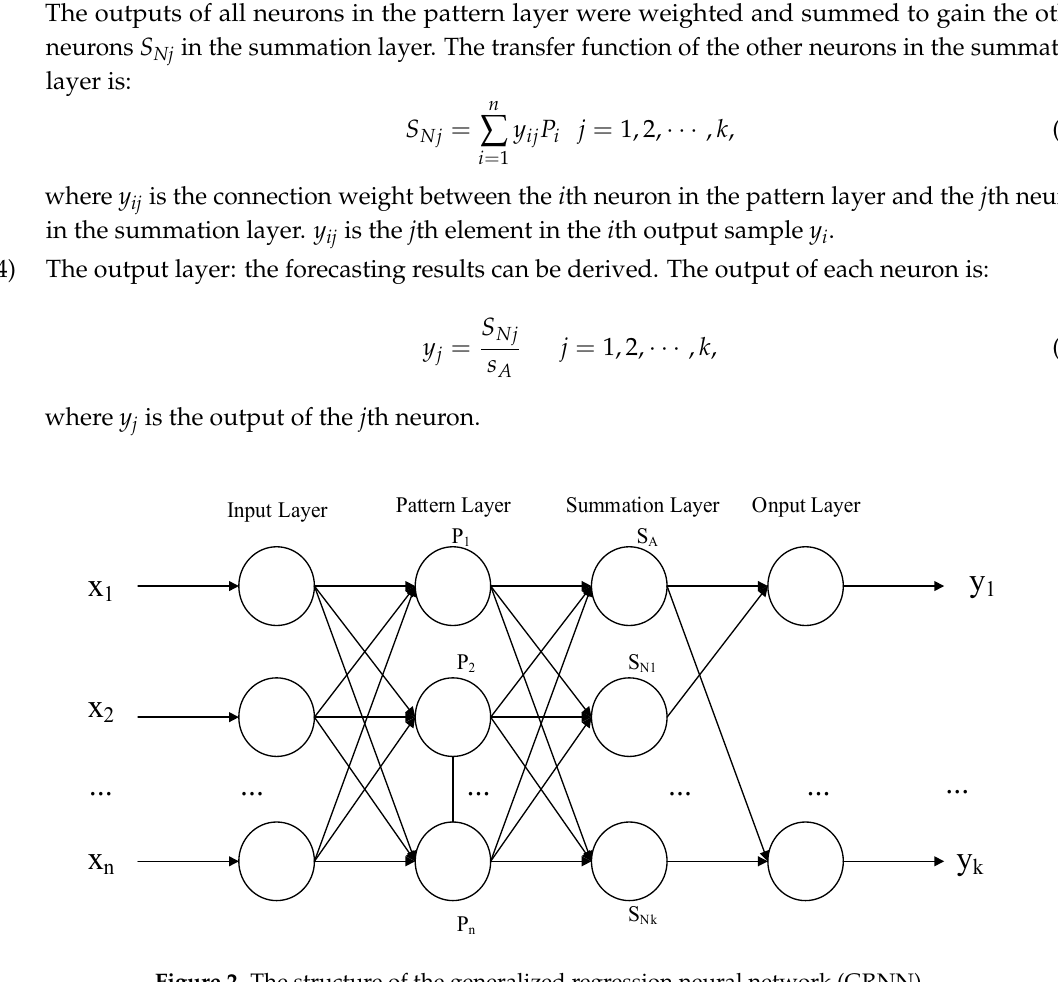
Figure 2. The structure of the generalized regression neural network (GRNN).